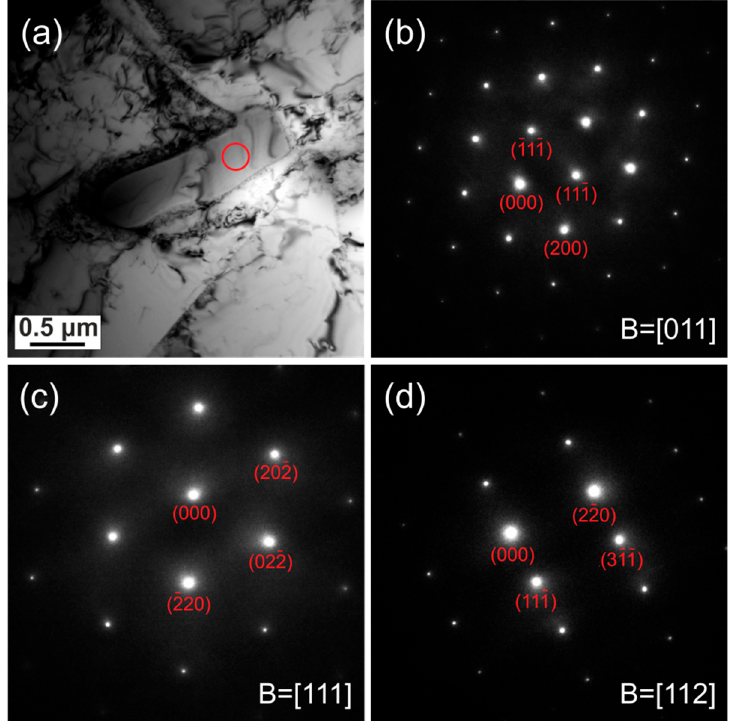
Figure 3. ( a ) Bright field transmission electron microscope (TEM) image of a typical primary carbonitride in the solution-treated Super304H steel. ( b–d ) are selected area electron diffraction (SAED) patterns of the carbonitrides taken along [011], [111] and [112] zone axis, respectively.